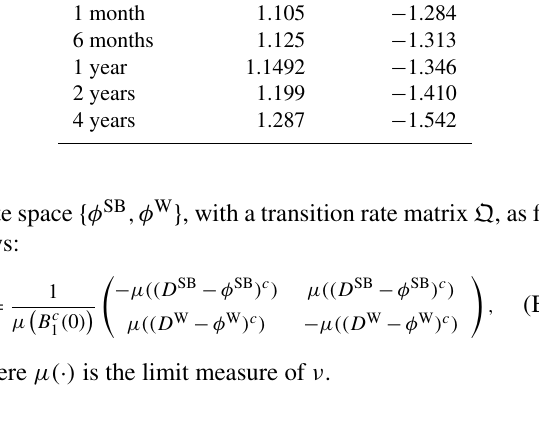
Table C1. Values of supercritical κ ..., u umn) and W → SB (third column) for different approximations (cid:49) τ (t) of Dirac’s δ(t) .